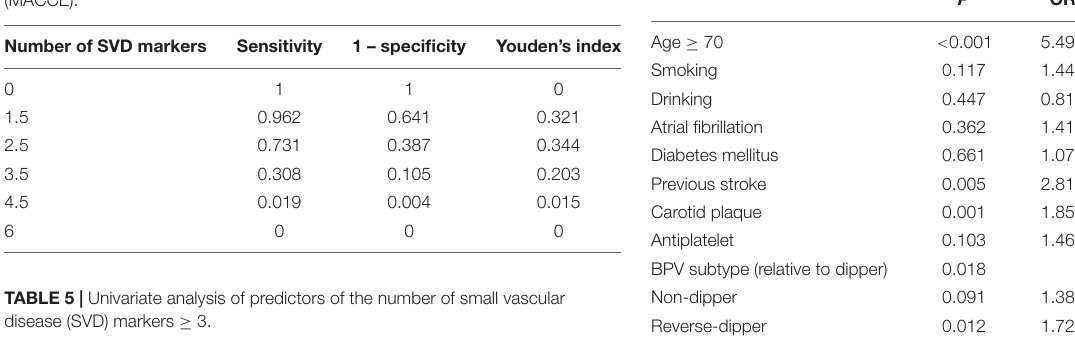
TABLE 6 | Multivariate analysis of predictors of the number of SVD markers ≥ 3.